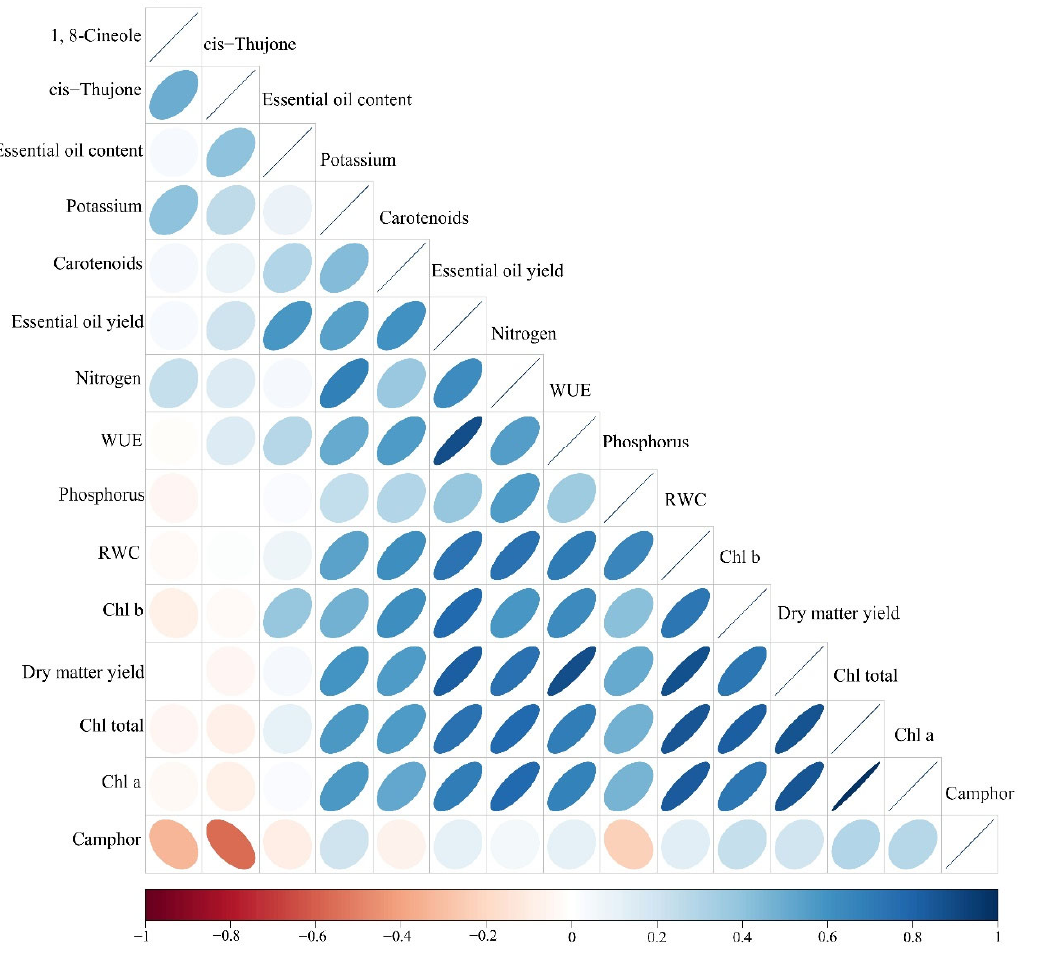
Figure 6. Pearson’s correlation matrix for studied traits of sage. Color ellipses illustrate statistically significant levels. Positive and negative correlations are shown in blue and red, respectively. The color legend on the bottom-hand side of corrplot represent the intensities of Pearson correlation coefficients.